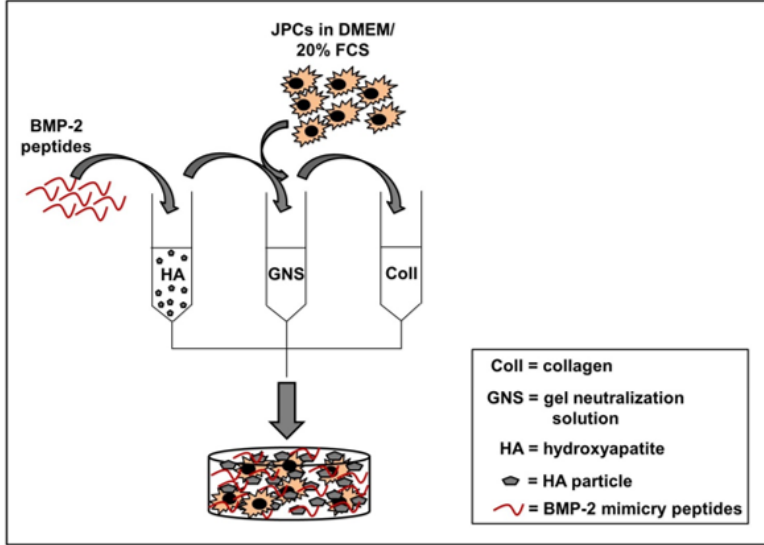
Figure 1. Preparation of collagen/HA composites. For the preparation of 3D composite scaffolds, BMP-2 mimicry peptides (200 µ g peptide per 10 mg HA) were added to hydroxyapatite (HA) and incubated for 2 h for binding. The functionalized HA was mixed with a gel neutralizing solution (GNS) and jaw periosteal cells (JPCs) in DMEM / 20% FCS were added. This mixture was combined with rat type I collagen (rat type I collagen, provided by Amedrix GmbH, Esslingen, Germany) solution. Direct distribution of the obtained solution in cell culture plates